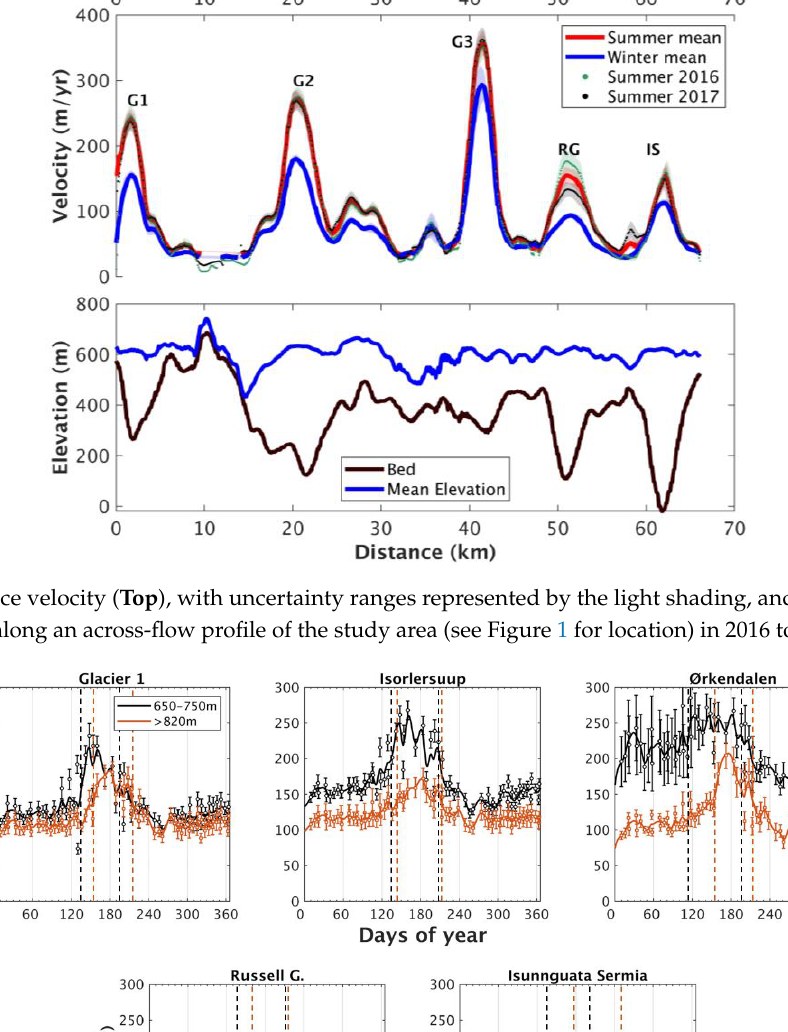
6 of 13 Figure 2. Mean summer and winter ice velocity ( a – e ) and geometry ( f – j ) along central profiles of five glaciers in west-central Greenland (see Figure 1 for glacier locations) in 2016 and 2017. Surface and bed elevations are from the Greenland Ice Mapping Project digital elevation model (GIMP-DEM) [54] and IceBridge BedMachine Greenland, Version 3 [58], respectively. Our velocity maps have sufficient spatial coverage to provide continuous profiles of summer and winter ice speed across the central flow unit of each glacier (Figure 3). Speedup is primarily confined to the central, fast flowing parts of each glacier and at ~600 m.a.s.l., peaks in the range of 22% (Ø G) to 66% (RG). At this altitude all of the glaciers sit in distinct bedrock depressions where the ice is far thicker than in the slower flowing neighbouring regions. In general, speedup is largely confined to fast-flowing glaciers or their tributaries (e.g., at 25–30 km and 58–60 km along the transect). Local variations in the input and routing of surface melt water may be responsible for this heterogeneity in the degree of seasonal ice speedup. With the exception of RG, the regional glaciers